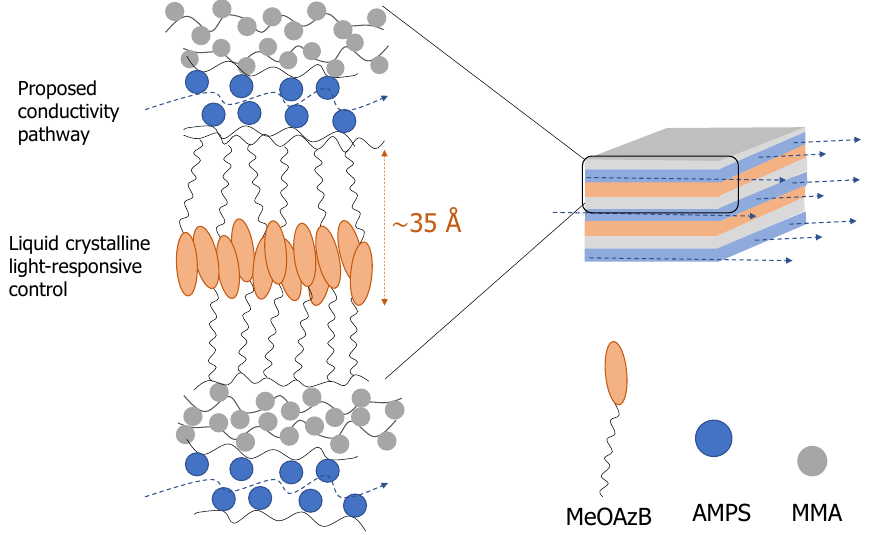
Figure 6. Schematic representation of the micro-segregated structure of the triblock copolymer, PA-b-PS-b-PM, including liquid crystalline regions and potential ionic conductivity pathways (dotted